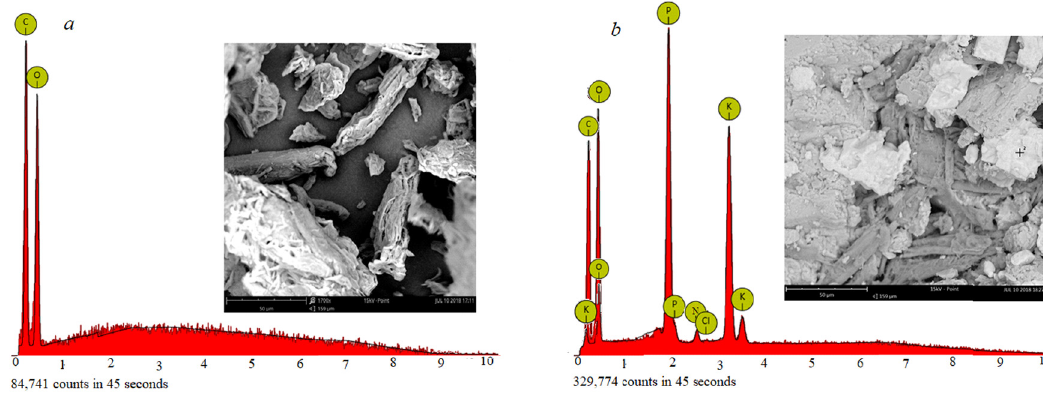
Figure 3: SEM photos and element distribution spectra of: ( a ) pure MC and ( b ) PDP granulated with MC and water and